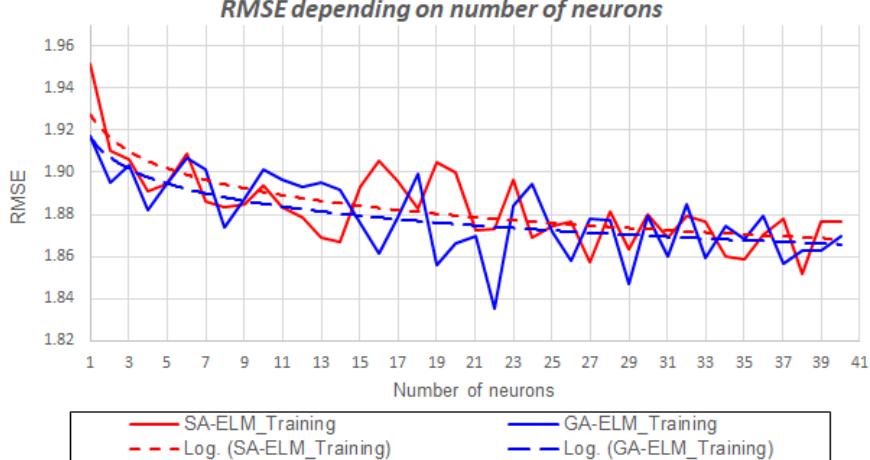
Fig. 9 . RMSE depending on number of neurons